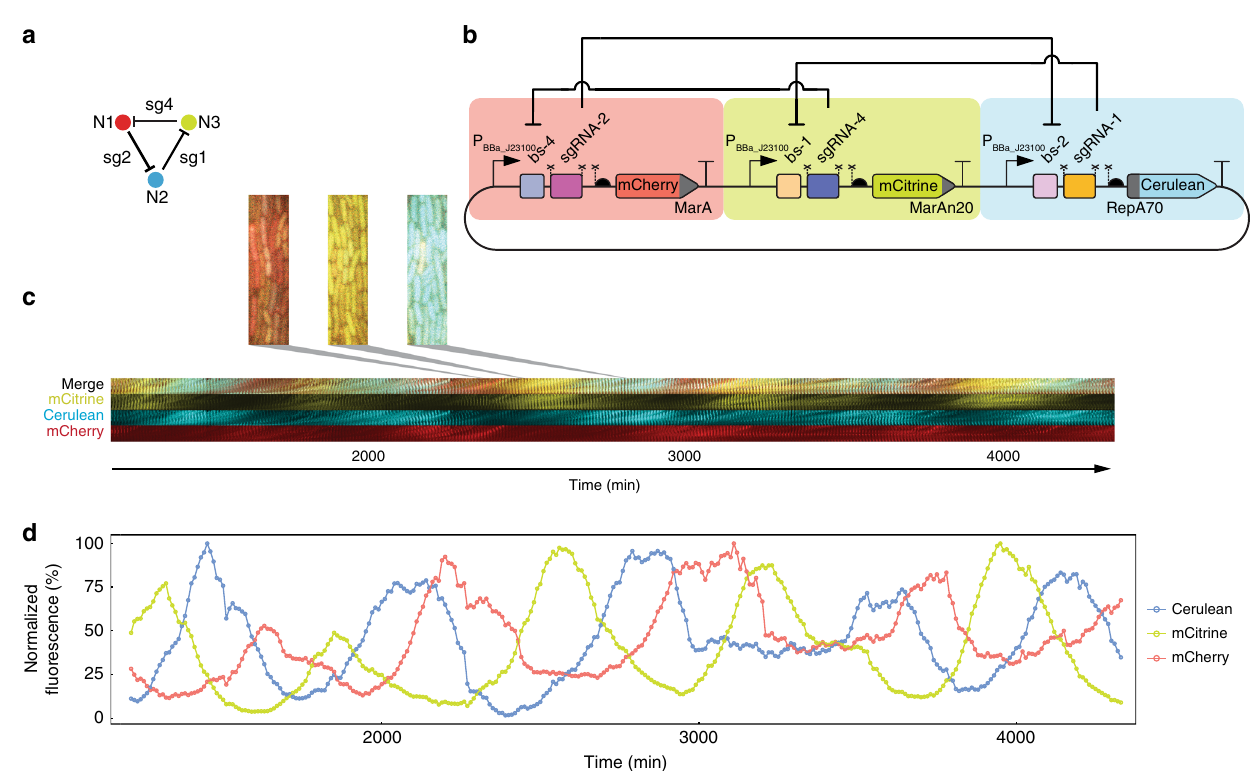
Fig. 5 The CRISPRlator, a CRISPRi-based oscillator. a Topology of the ring oscillator. b Molecular implementation of the CRISPRlator. Symbols as described in Fig. 1. c Montage showing the oscillations of the three fl uorescent reporters over time. Bacteria were grown in continuous exponential phase in a micro fl uidic device for 3 days and imaged every 10 min. Microscopy images (as those enlarged in the zoom-ins) are displayed together in a timeline montage (kymograph). d Quanti fi cation of the population-level fl uorescence of ~110 cells over time. Oscillations display a period of 10 – 12 h. Source data are provided as a Source Data fi